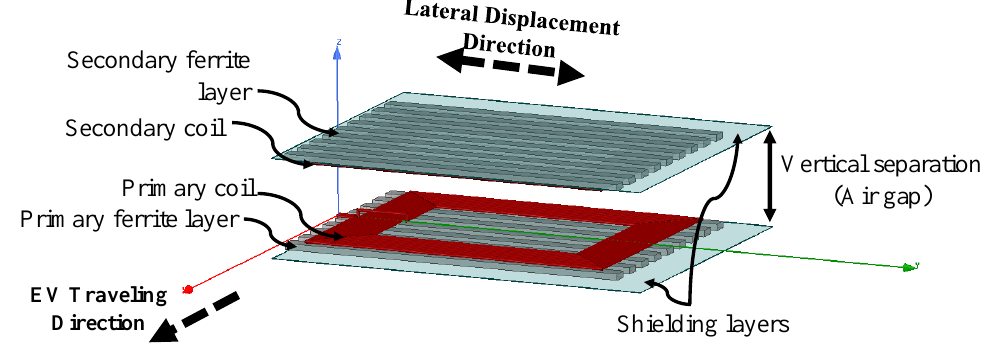
Figure 2. Cross-section of the inductive link showing its different layers. Each charging coil can be characterized using its self-inductance, L i , and its equivalent series resistance, ESR, R i , where the subscript i defines the side on which the coil is placed, such that i = p indicates the primary side and i = s indicates the secondary